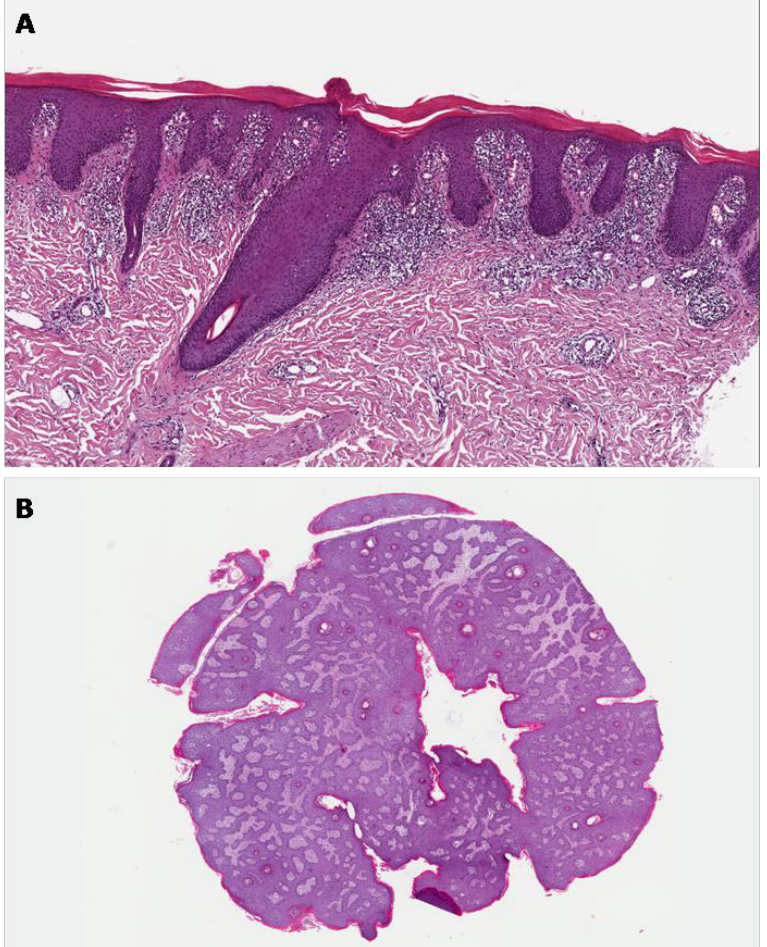
Figure 1. ( A ) Conventional histopathology of psoriasis: elongated rete ridges, alternating areas of hypo- and hypergranulosis, thinning of the suprapapillary plates and Munro microabscesses are seen (hematoxylin and eosin; original magnification 150×); ( B ) Horizontal histopathologic image from psoriasis showing a better correlation with the horizontal plane observed by dermoscopy and RCM; the psoriasiform pattern of rete ridges is seen (hematoxylin and eosin; original magnification 25×).